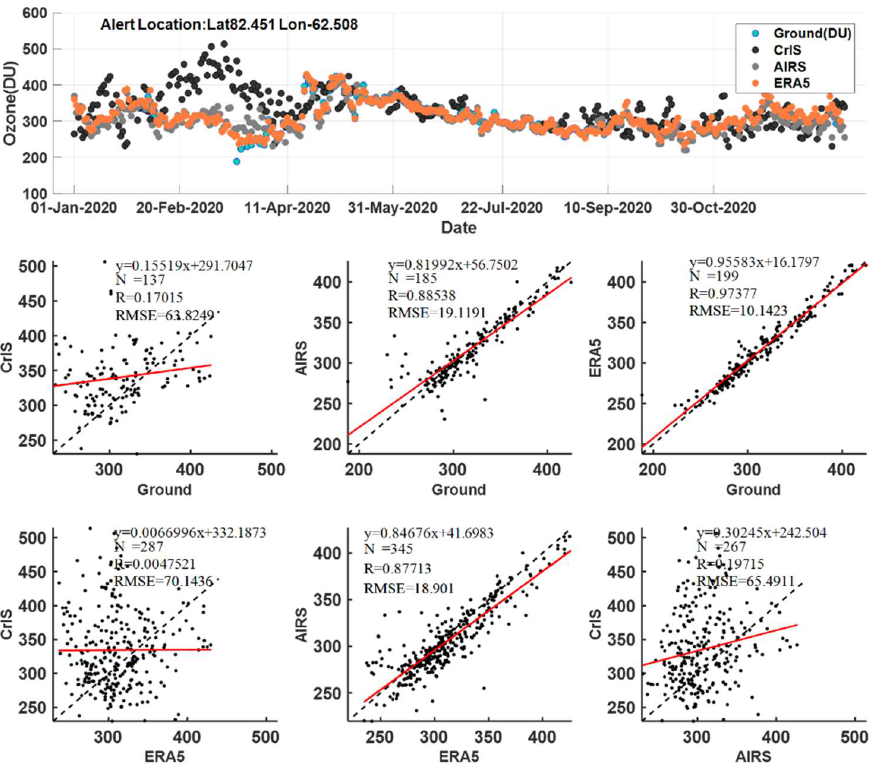
Figure 4. The comparison of total column ozone between matched CrIS/AIRS/ERA5 and ground- based instruments at Alert site. (Upper row) the time series of total column ozone; (Middle and bottom rows) inter-comparison scatter plots.